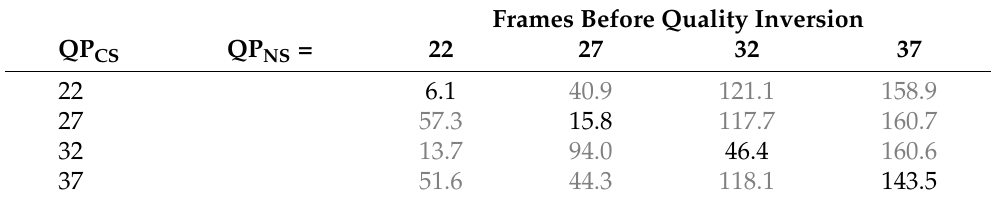
Table 3. Average number of frames (after keyframe insertion) where KI src has a better VMAF score